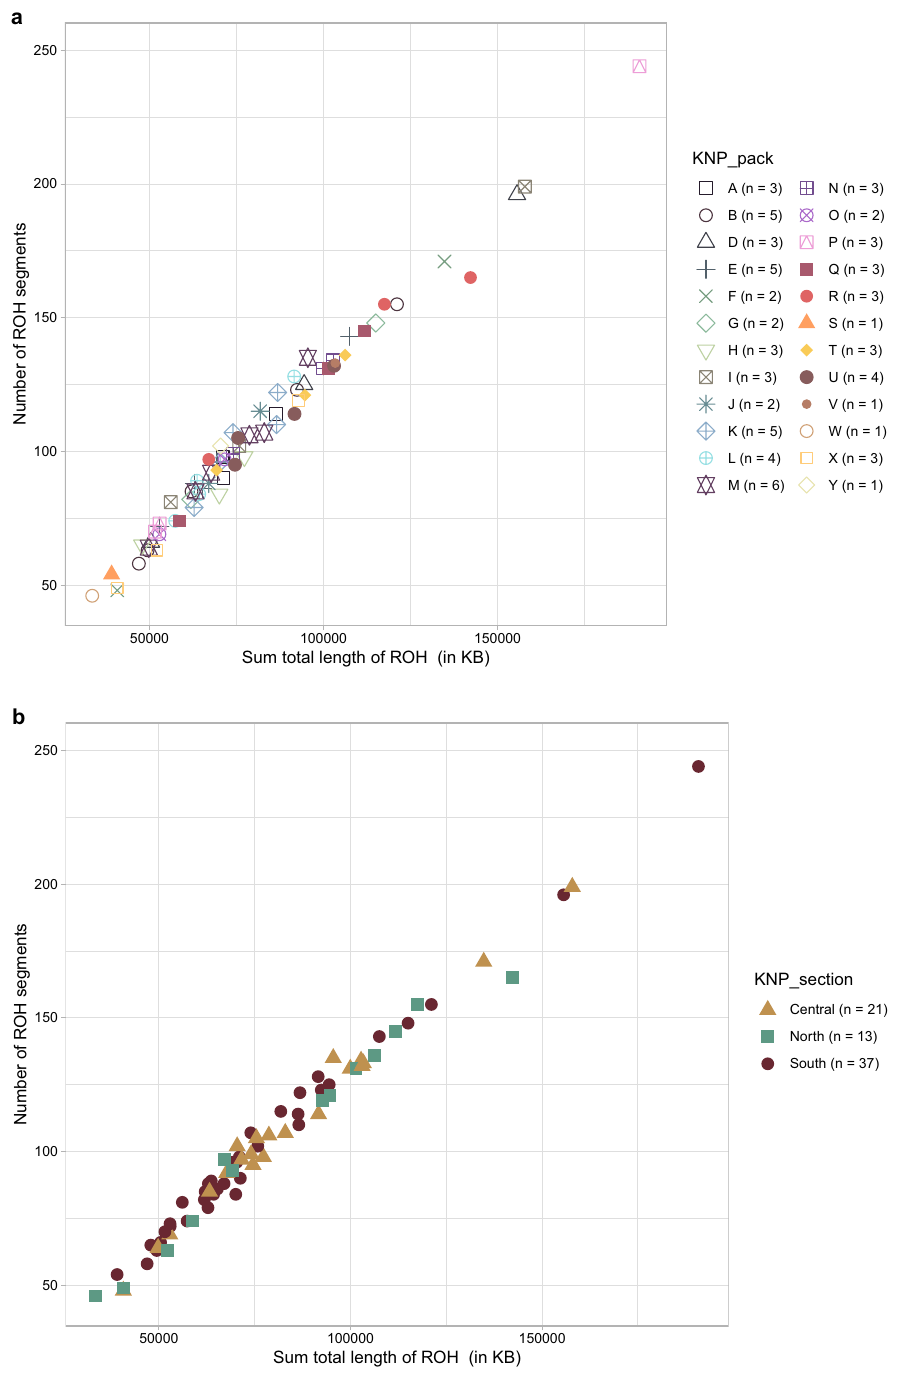
Figure 4. Total genomic length (kilobase pairs) covered by runs of homozygosity (ROH) per individual (x-axis) and total number of ROH per individual (y-axis) of African wild dogs ( Lycaon pictus ) from Kruger National Park (KNP), South Africa. ( a ) Each data point in the plot represents an individual, with the coloured shapes corresponding to the pack (KNP_pack). ( b ) Colours and shapes correspond to an individual’s geographical location in